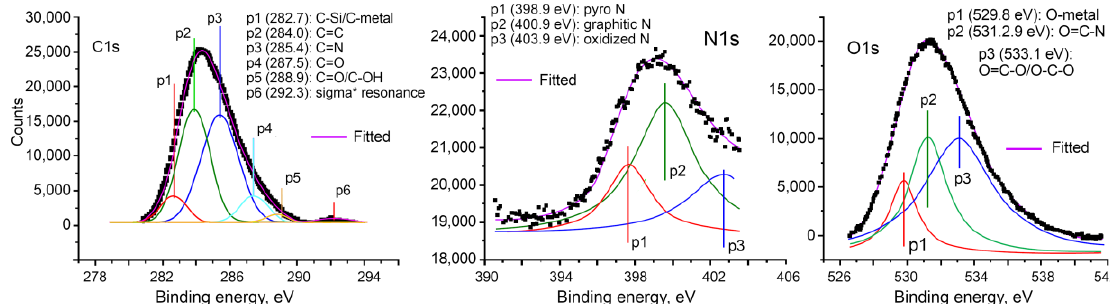
Figure 5. Deconvolution of the carbon, nitrogen and oxygen peaks of the general XPS spectra (Figure 4c) of the 3D nitrogen self-doped graphene-based carbon aerogel activated at 800 °C.